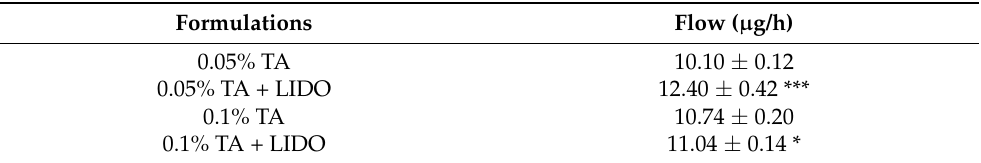
Table 4. Amount of TA permeated in sublingual tissue per hour (flow). Values represent Mean ± SD ( n = 5). Significant differences versus formulation with the same concentration of TA but without LIDO: * ( p < 0.05), *** ( p <